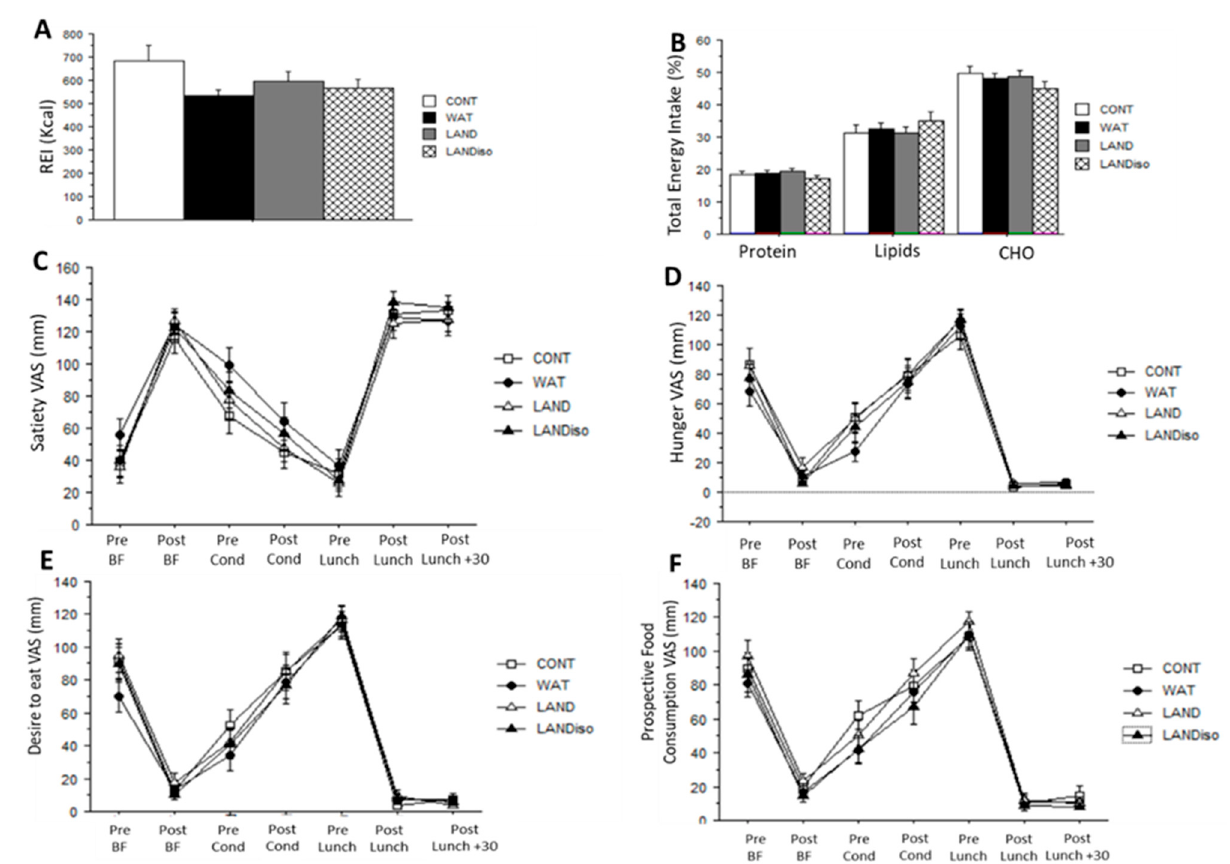
Figure 3. Food intake and appetite sensations. ( A ) Relative energy intake (REI), ( B ) macronutrients in percentage of total energy intake, ( C ) satiety feelings, ( D ) hunger feelings, ( E ) desire to eat feelings, ( F ) prospective food consumption, are presented for control (CONT), water-cycling (WAT), land-cycling (LAND) and land isoenergetic cycling (LAND-Iso) sessions. Data are presented as mean ± SD, significant difference is set at p < 0.05.